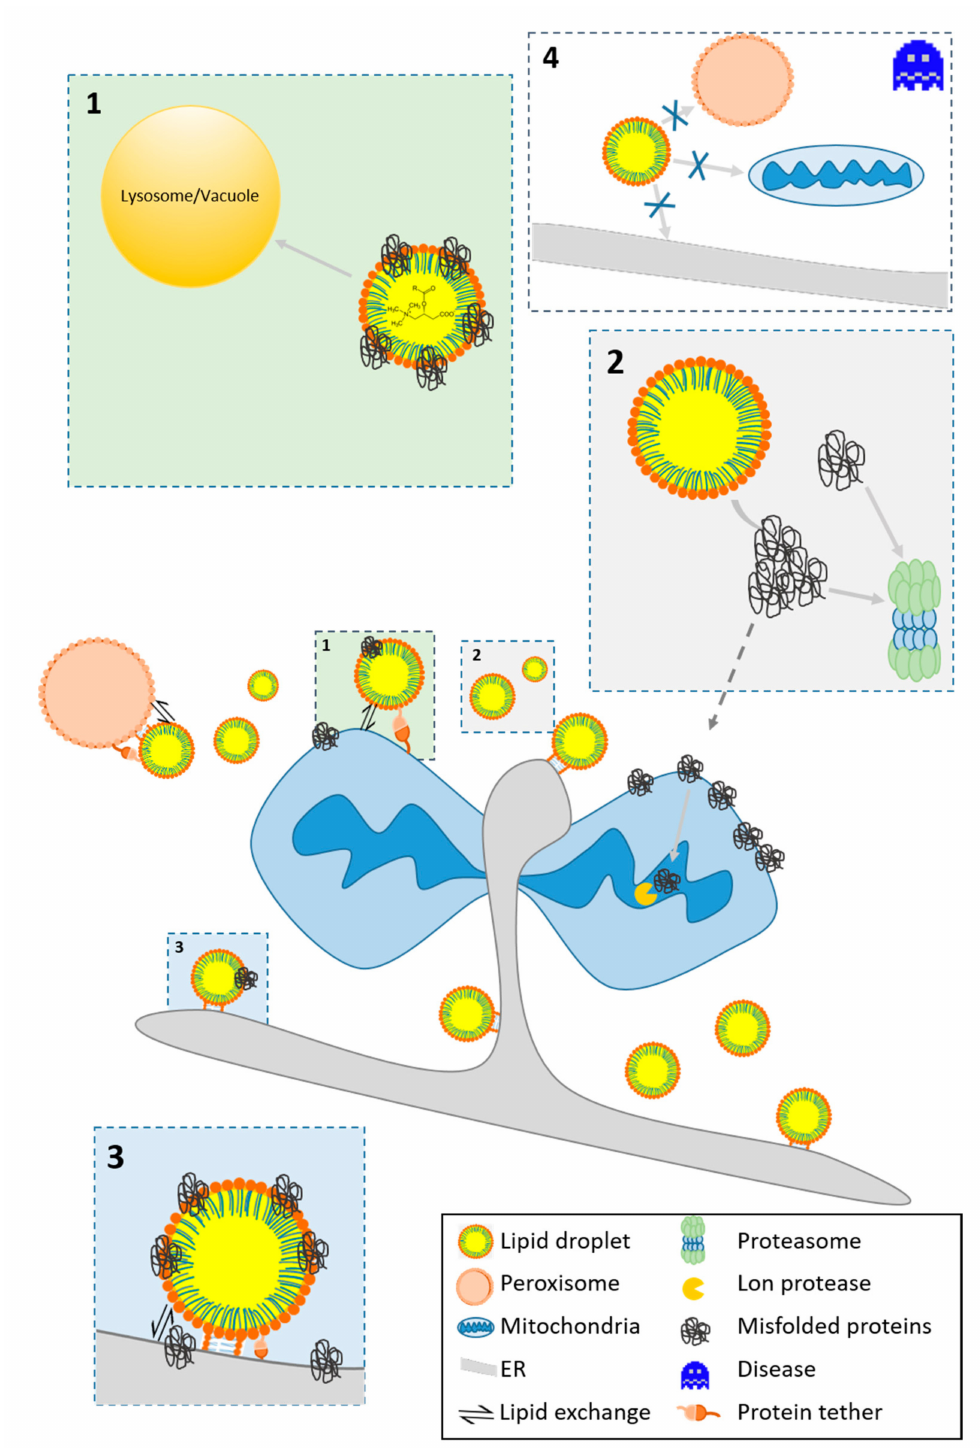
Figure 1. LDs as a storage organelle. In a trimeric complex LDs show a strong association with the ER and mitochondria. LDs constantly bud off the ER (birth of LDs) and are degraded in the vacuole / lysosome inanautophagicprocesscalledlipophagy(deathofLDs)( 1 ). Duringitslife,LDsfulfilamultitudeoffunctions. Among them is the role of LDs in protein homeostasis. LDs assist the 26S proteasome in dissolving protein aggregates by sequestering sterol derivatives ( 2 ). Stabilized by a protein tether and a lipidic bridge LDs interact with the ER and take up misfolded proteins after ERAD malfunction. Additionally, toxic lipids (e.g., lipid peroxides, acylceramides) accumulate in LDs ( 3 ). Similarly, harmful mitochondrial proteins can berelocalizedfromtheOMMtoLDs. Finally, theseloadedLDsdegradeinthelysosome / vacuole( 3 ). Afailure in interorganelle contacts results in a multitude of disease (especially neurodegenerative diseases) ( 4